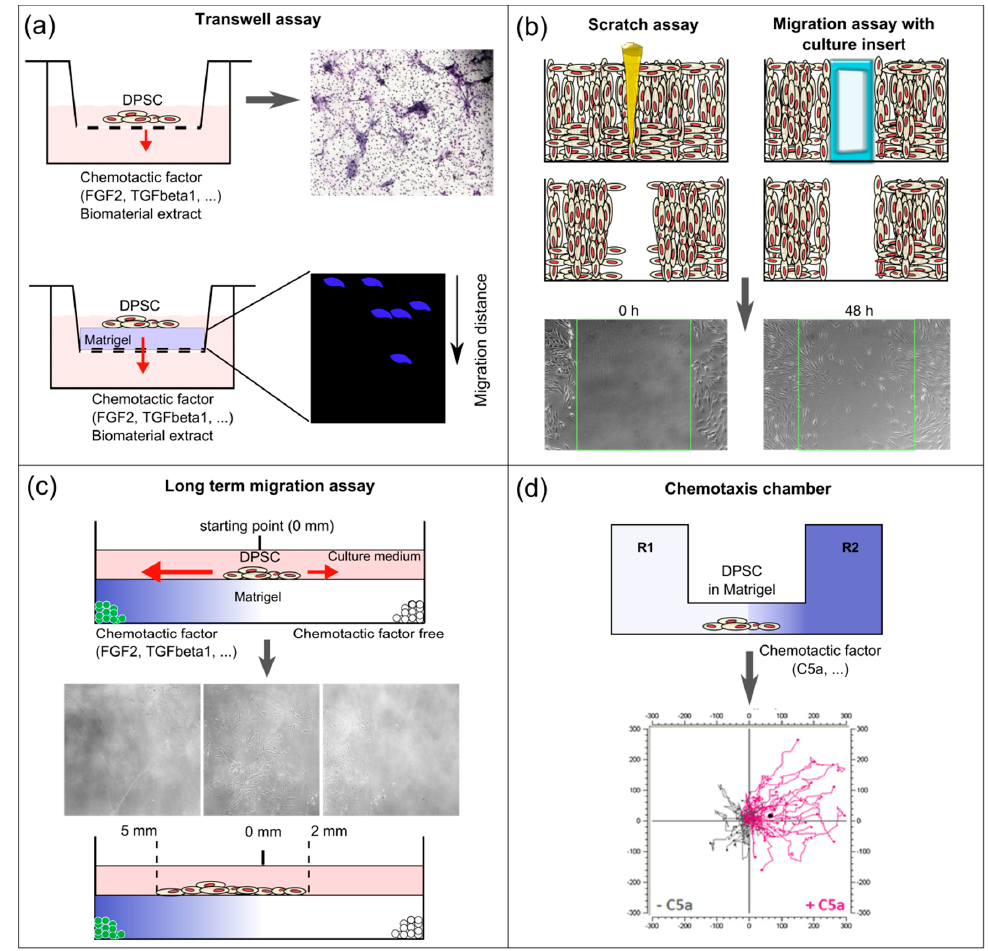
Figure 2. Schematic overview of the different in vitro assays used to study DPSC recruitment and migration. ( a ) On the upper panel, a classical Trans-well assay used to evaluate the chemotactic potential of bioactive molecules and biomaterials (extracts), with cells seeded on the upper side of the membrane. Results are obtained by swabbing the non-migrated cells from the upper side of the membrane followed by histological staining of the migrated cells on the lower side of the membrane. These can be counted and quantified. On the lower panel, a modified Trans-well assay where the porous membrane is coated with an extracellular matrix (ECM)-like gel (e.g., Matrigel, collagen), on which cells are seeded. Gels can be retrieved to evaluate the migrated distance of cells (e.g., by cell nuclear staining using 4’,6-diamidino-2-phenylindole (DAPI) (blue) and confocal microscopy); ( b ) On the left, scratch assay to evaluate cellular migration. A scratch is made (usually using a pipette point) on confluent cell cultures. On the right, a modified assay to study cellular migration is represented. A culture insert is placed, around which cells are cultured. When the culture is confluent, the insert is removed leaving behind a reproducible cell-free zone with sharp borders, as opposed to the scratch assay. With both techniques, cellular migration into the cell-free zone is followed up microscopically and can be quantified using specialized software. A chemotactic gradient is absent in these assays; ( c ) Culture model to study long-term migration following the controlled release of chemotactic factors. Poly(lactic-co-glycolic acid) (PLGA) microspheres with or without chemotactic factors are embedded in Matrigel in a graduated tissue culture chamber. DPSC are seeded in the middle and their migration can be followed microscopically over long time periods (up to 10 days); ( d ) Specialized in vitro chemotaxis chamber. A stable chemotactic gradient is established by injecting a solution of chemotactic factor in one of the reservoirs. Cells are seeded in the observation area containing Matrigel in the middle of the chamber. Real-time monitoring of cellular migration can be performed up to 48 h. Quantitative evaluation is carried out by specialized software. Individual cells are tracked and the center of mass (CAM) is calculated. Trajectory plots can be presented